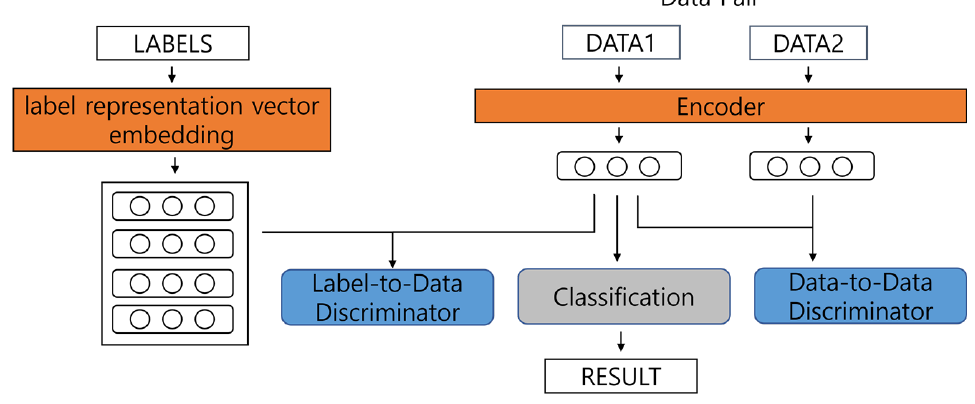
Figure 1. Overall architecture of proposed framework with